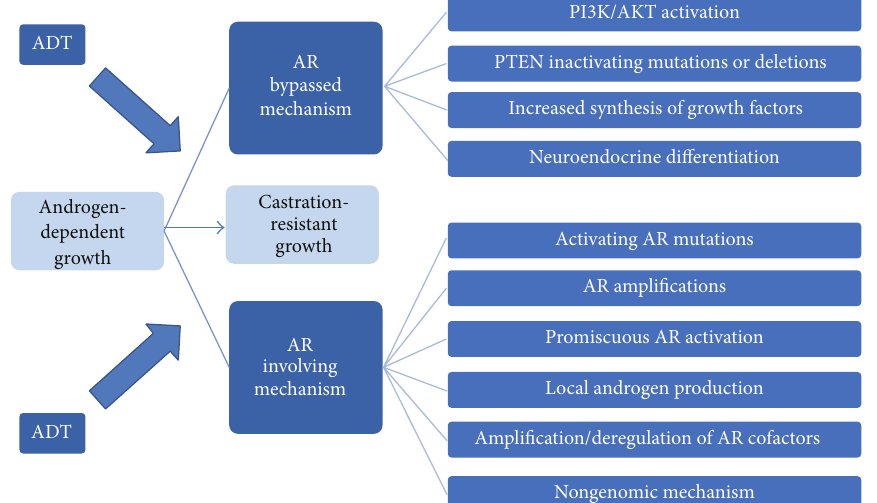
Figure 1: Schematic representation of the main pathways involved in development of castration-resistant prostate cancer (CRPC). ADT: androgen-deprivation therapy, AR: androgen receptor. Modified from